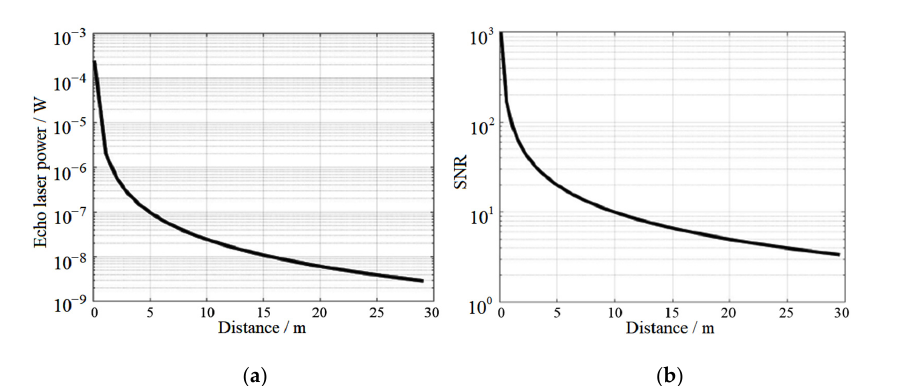
Figure 3. Echo laser power ( a ) and SNR ( b ) with the detection